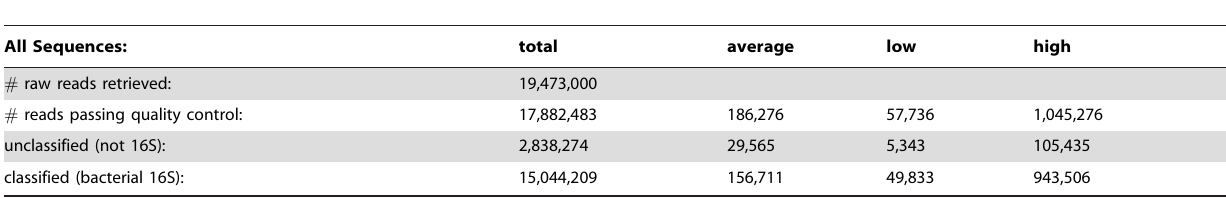
Table 1. Summary of Sequencing